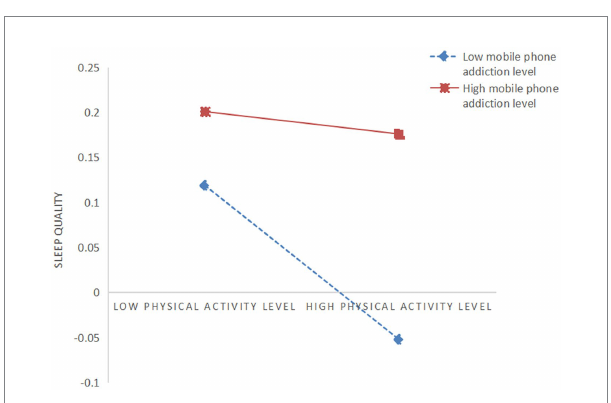
FIGURE 5 The moderating effect of mobile phone addiction on the relationship between physical activity and sleep